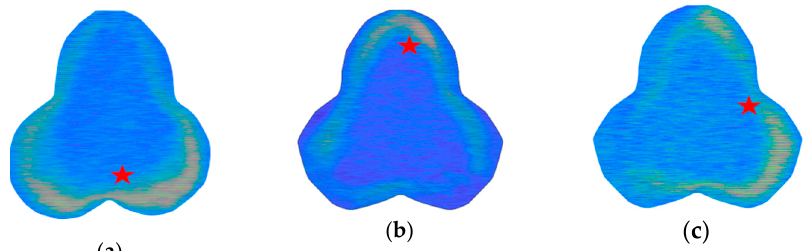
Figure 5. Images collected with the charge coupled device (CCD) camera after bending the three-lobe plastic fiber. Red stars indicate the position of the weighted centroid found from the converted gray-scale image. The curvature center placed: ( a ) on the upper surface of the fiber; ( b ) on the lower surface of the fiber; ( c ) on the right-hand surface of the fiber.